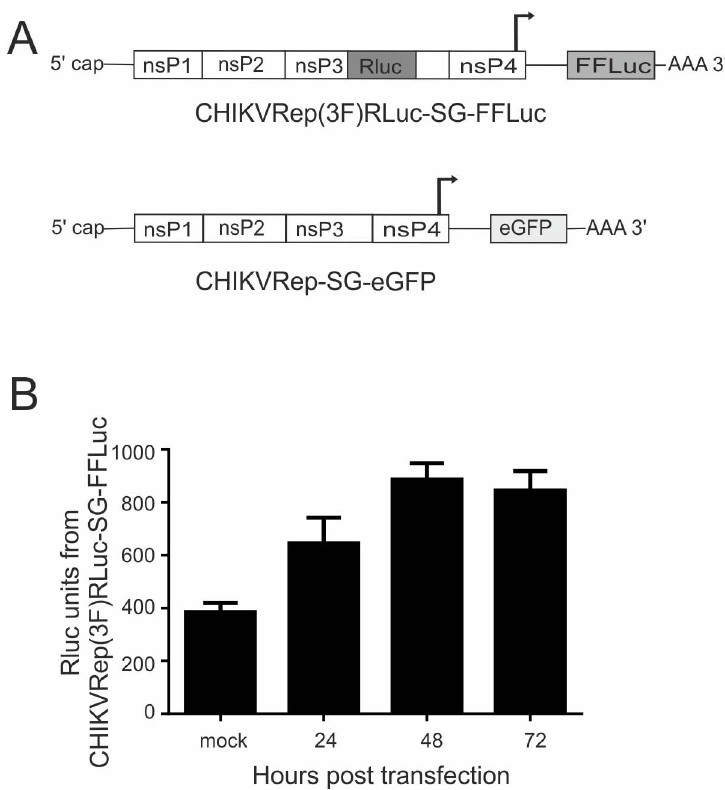
Figure 1. Replication of CHIKVRep(3F)RLuc-SG-FFLuc in Aag2 cells. ( A ) Schematic representation of CHIKV replicons. RLuc was inserted into the C-terminal region of the nsP3 protein and sequence encoding for FFLuc was cloned in place of the structural open reading frame under the control of the subgenomic promoter to give CHIKVRep(3F)RLuc-SG-FFLuc. A second replicon with no reporter in the non-structural open reading frame and coding sequence of eGFP cloned under control of the subgenomic promoter was created, CHIKVRep-SG-eGFP. ( B ) Aag2 cells were transfected with in vitro transcribed CHIKVRep(3F)RLuc-SG-FFLuc RNA and RLuc activity measured 24, 48 or 72 h post transfection (hpt). Graph shows the mean RLuc readings from a representative single experiment carried out in triplicate. Error bars show the standard error of mean. Three independent experiments have been carried out in triplicate.